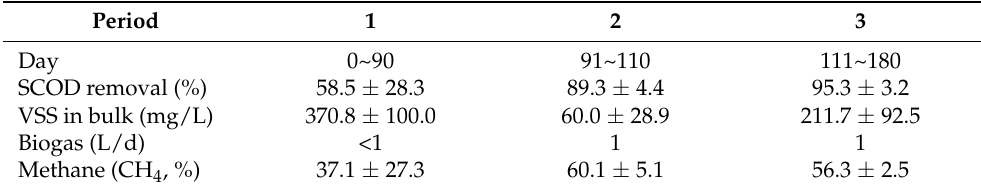
Table 3. The mean value of AFMBR performance during each operational